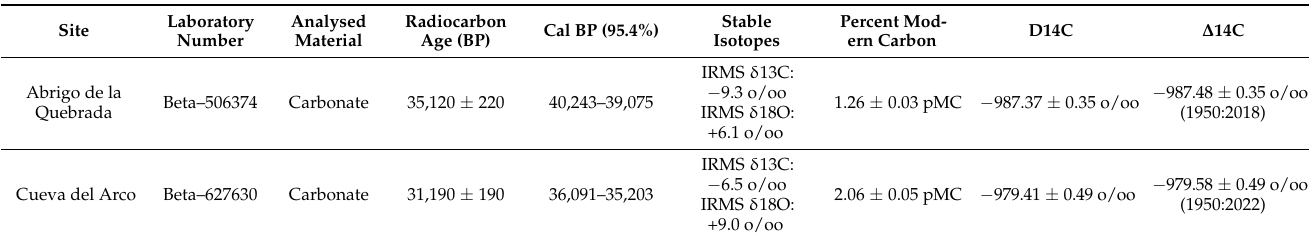
Table 6. Radiocarbon dating results of Celtis endocarps.